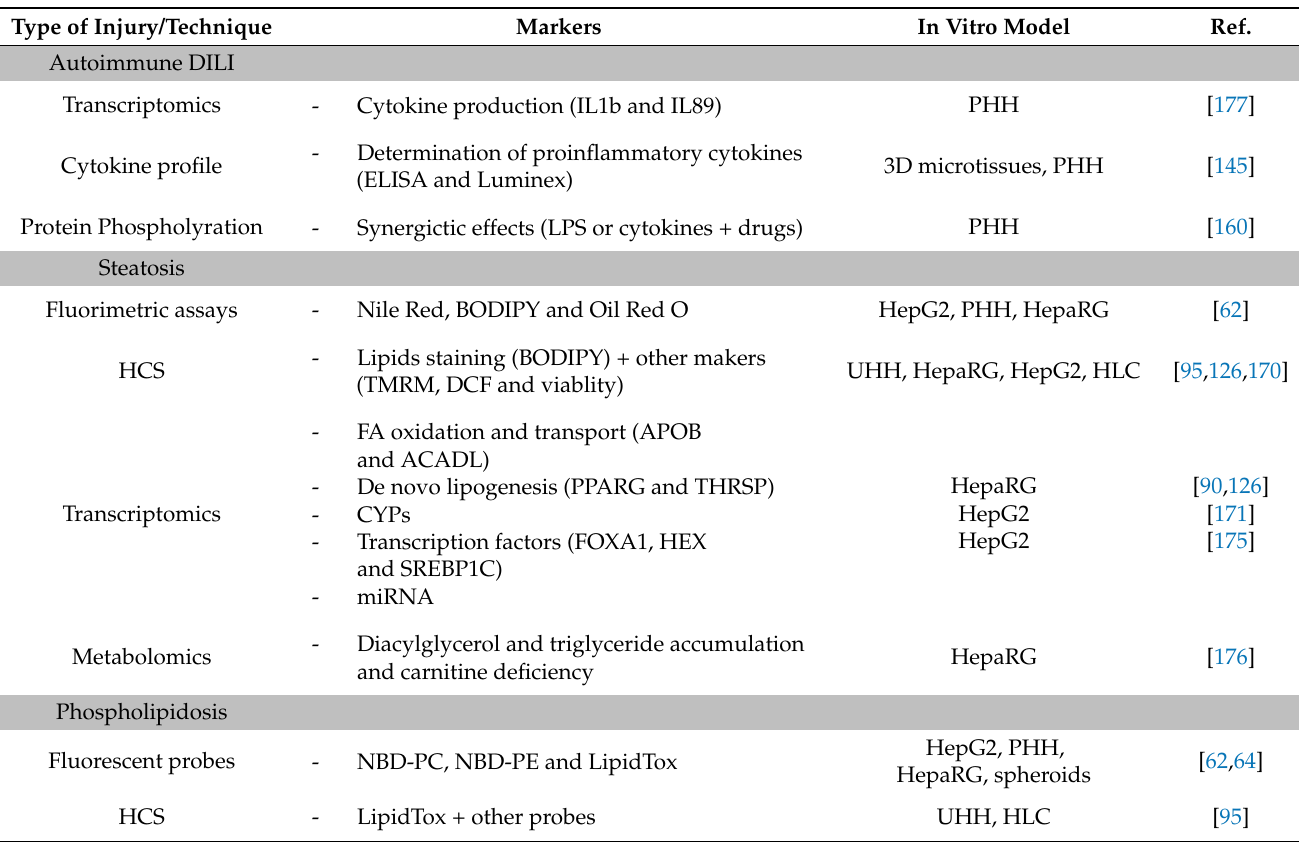
Table 3. Techniques used to specifically assess chronic hepatotoxicity.